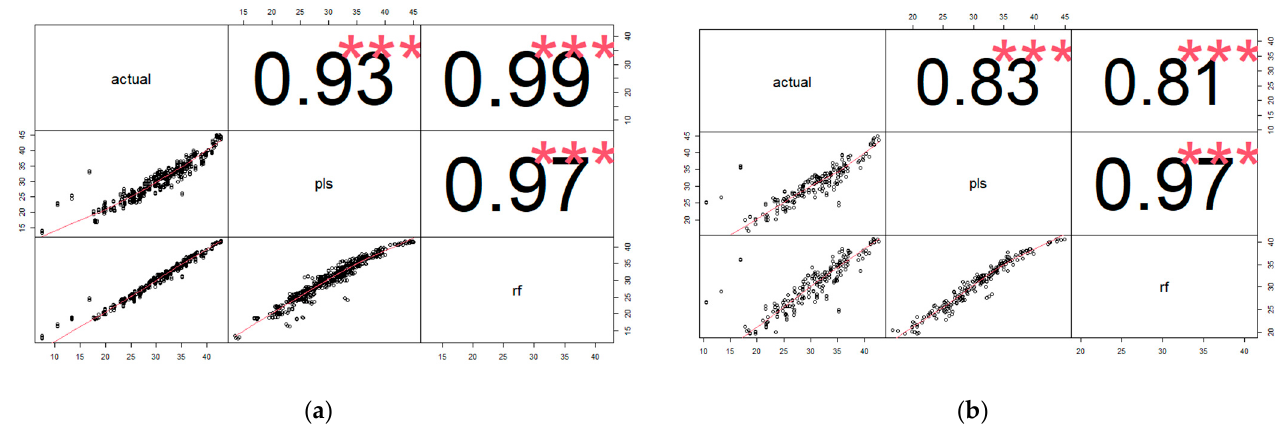
Figure 5. Correlation between actual and predicted DMC values using PLS and RF calibration models in the training ( a ) and validation sets ( b ).